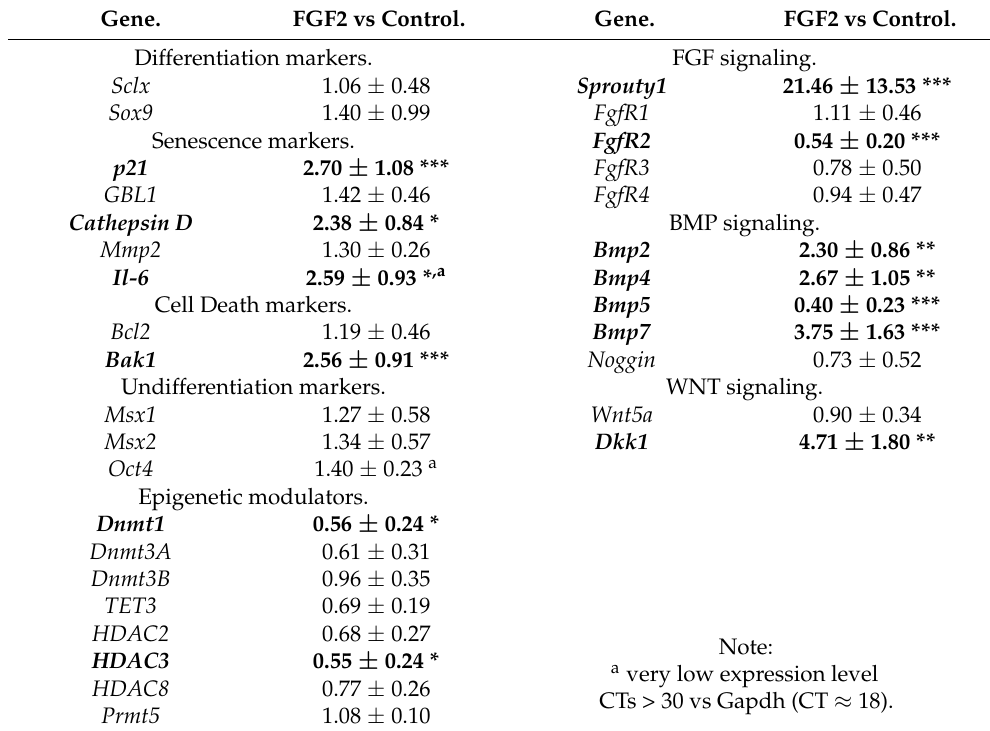
Table 1. Gene expression fold change values in FGF-treated versus control untreated, two-day- old micromass cultures. Fold change values are expressed as Mean ± SD. * p < 0.05; ** p < 0.01; *** p < 0.001. a very low expression level. Bold is regulated genes. Gene. FGF2 vs Control. Gene. FGF2 vs Control. Differentiation markers. FGF signaling. Sclx 1.06 ± 0.48 Sprouty1 21.46 ± 13.53 *** Sox9 1.40 ± 0.99 FgfR1 1.11 ± 0.46 Senescence markers. FgfR2 0.54 ± 0.20 *** p21 2.70 ± 1.08 *** FgfR3 0.78 ± 0.50 GBL1 1.42 ± 0.46 FgfR4 0.94 ± 0.47 Cathepsin D 2.38 ± 0.84 * BMP signaling. Mmp2 1.30 ± 0.26 Bmp2 2.30 ± 0.86 ** Il-6 2.59 ± 0.93 * ,a Bmp4 2.67 ± 1.05 ** Cell Death markers. Bmp5 0.40 ± 0.23 *** Bcl2 1.19 ± 0.46 Bmp7 3.75 ± 1.63 *** Bak1 2.56 ± 0.91 *** Noggin 0.73 ± 0.52 Undifferentiation markers. WNT signaling. Msx1 1.27 ± 0.58 Wnt5a 0.90 ± 0.34 Msx2 1.34 ± 0.57 Dkk1 4.71 ± 1.80 ** Oct4 1.40 ± 0.23 a Epigenetic modulators. Dnmt1 0.56 ± 0.24 * Dnmt3A 0.61 ± 0.31 Dnmt3B 0.68 ± 0.27 Note: HDAC3 a very low expression level 0.77 ± 0.26 CTs > 30 vs Gapdh (CT ≈ 18). Prmt5 1.08 ±